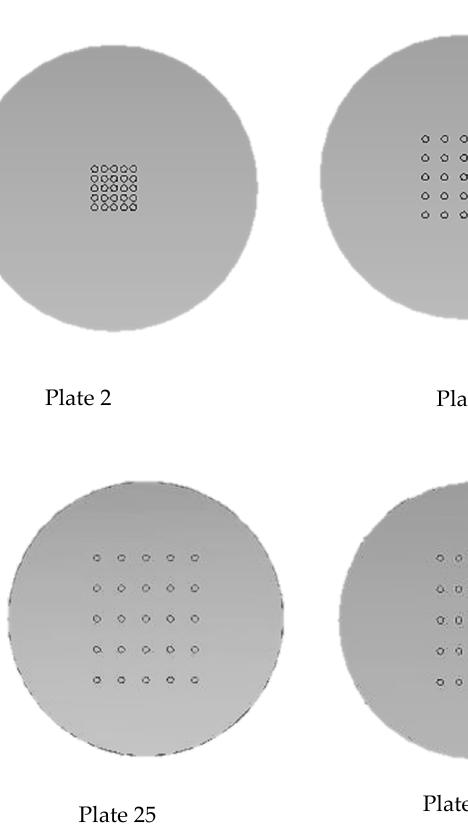
Figure 4. An example of six perforated plate configurations. Table 1. Geometric features of the plates resolved by CFD.